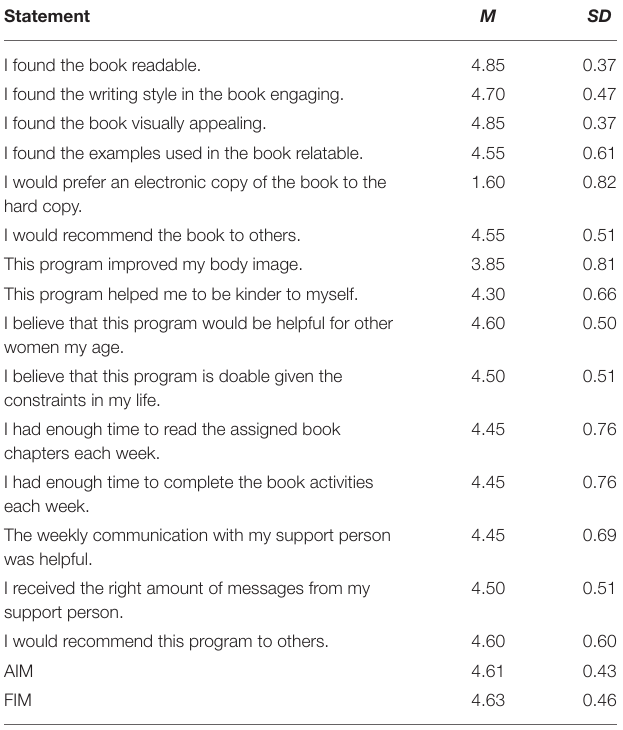
TABLE 2 | Feedback questionnaire